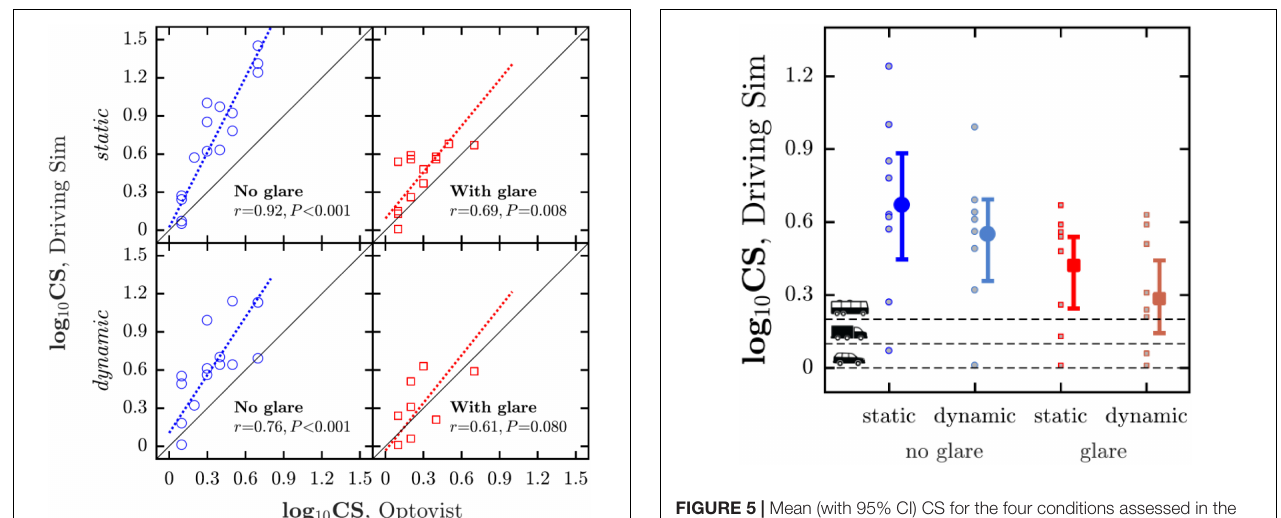
FIGURE 5 | Mean (with 95% CI) CS for the four conditions assessed in the driving simulator. Horizontal dashed lines indicate the minimum CS requirements in Germany for three classes of vehicular driving licenses. Markers show the values for each individual participant. See Supplementary Figure 1 for an equivalent figure in which the four corresponding data points for each individual participant are connected by